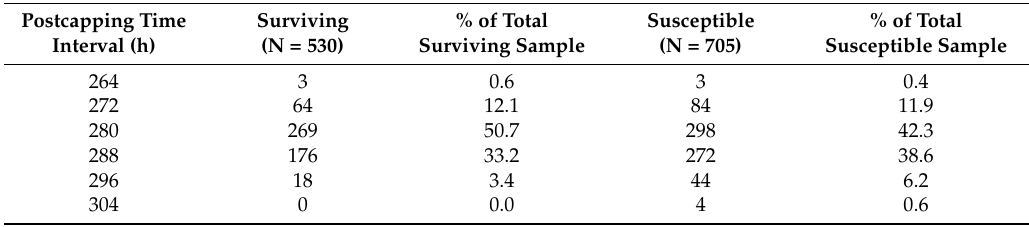
Table 1. Number of worker bees emerging within the designated 8-h time bins. A higher proportion of surviving worker bees emerged at intervals earlier than their susceptible